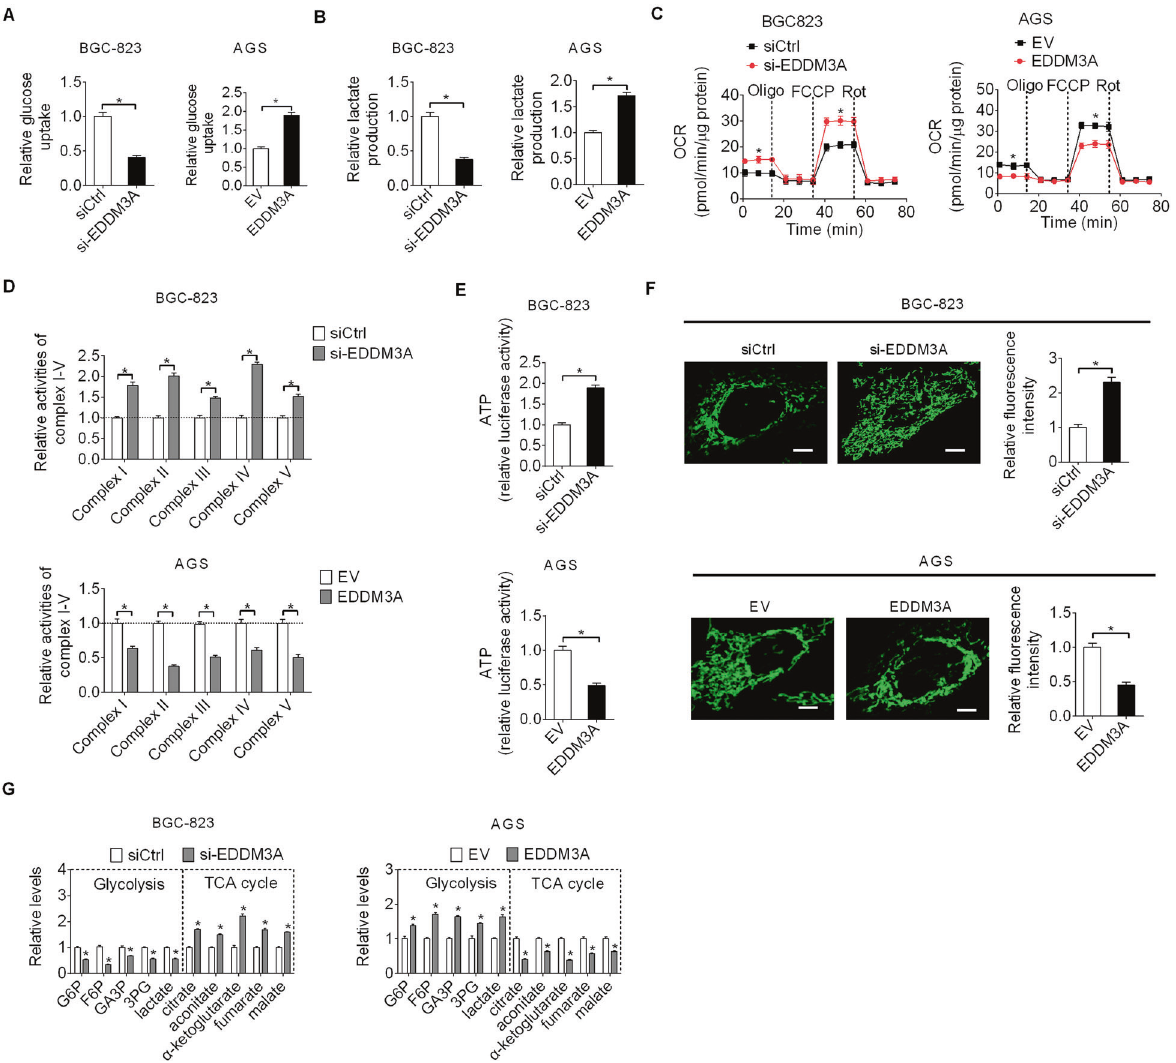
Fig. 6 EDDM3A promotes aerobic glycolysis in GC cells. A , B The effects of EDDM3A knocking down or overexpressing on glucose uptake and lactate production were determined in BGC-823 and AGS cells. C – E Effects of EDDM3A knocking down or overexpressing on mitochondrial oxygen consumption rate ( C ), OXPHOS complexes activities ( D ), and ATP production ( E ) were determined in BGC-823 and AGS cells. F Confocal microscopy assay for mitochondrial mass in BGC-823 and AGS cells with EDDM3A knocking down or overexpressing. Scale bars, 2 μ m. G The levels of metabolites involved in glycolysis and TCA cycle were determined in BGC-823 and AGS cells with EDDM3A knocking down or